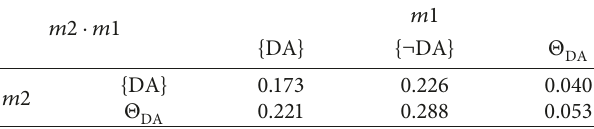
Table 10: Product of bpa of mass functions m 1 and m 2.